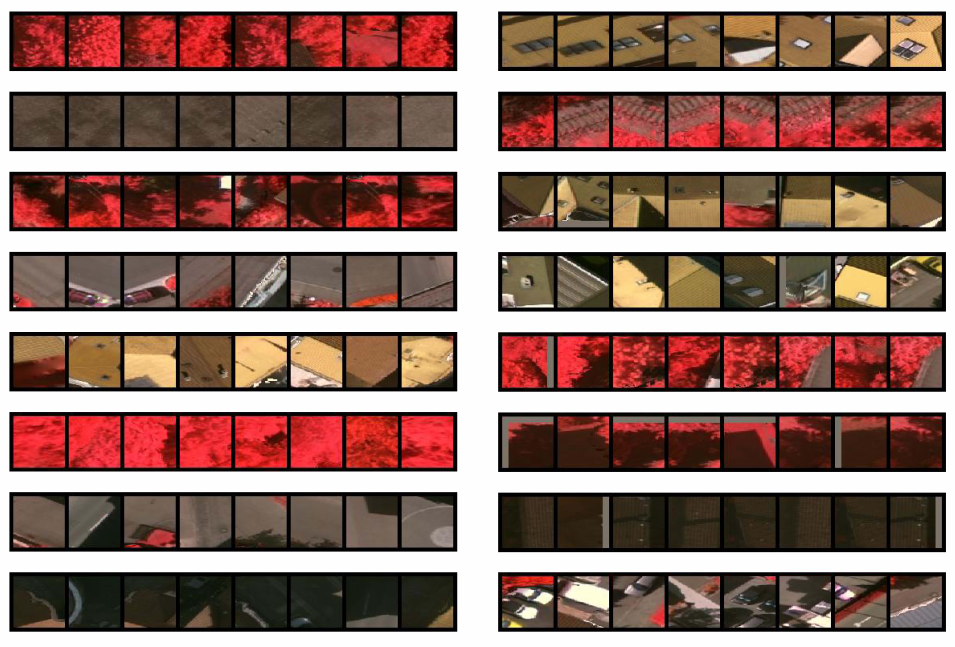
Figure 4. Examples of visual-word members from the conv4 layer of